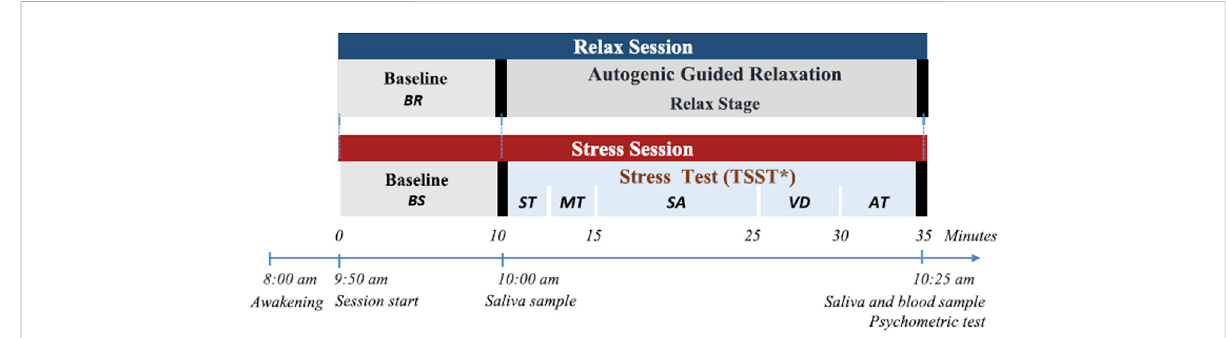
Experimentaldesignsessions.BR:Baselinerelax.BS:Baselinestress.ST:StoryTelling.MT:Memorytest.SA:Stressanticipation.VD:Publicvideo display. AT: Arithmetic